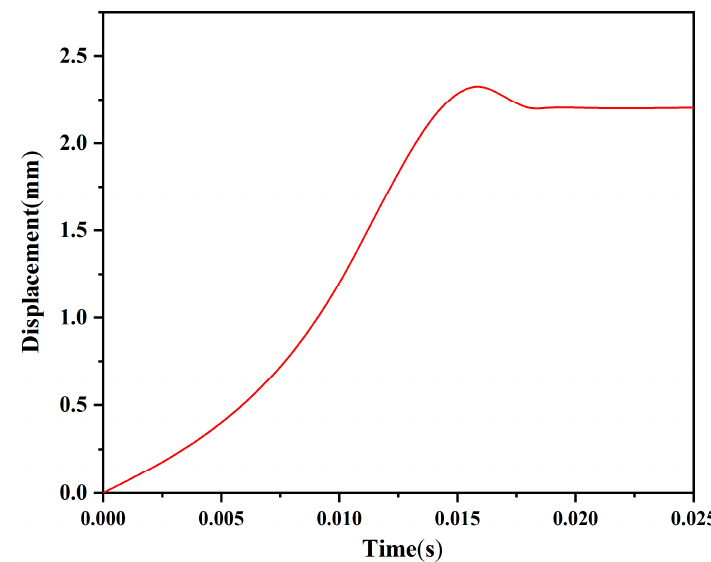
Figure 12. Time–displacement curve of the head latch.